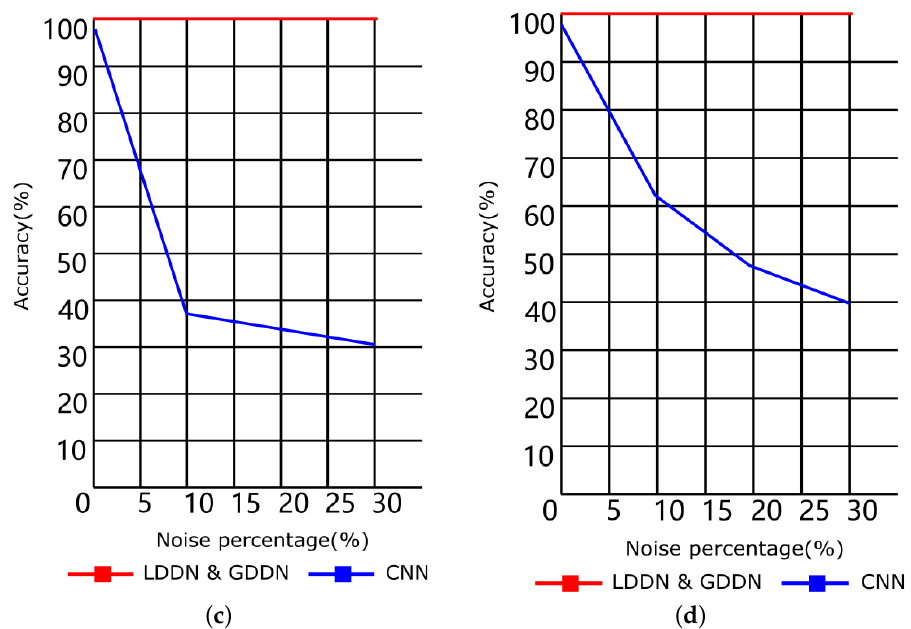
Figure 13. Line graph which compares the accuracy rates of LDDN and GDDN as well as CNN in comparison experiments with various percentages of noise added to the grayscale background. Among these four images, ( a ) depicts an experiment with the object of 4 pixels, ( b ) depicts an experiment with the object of 16 pixels, ( c ) depicts an experiment with the object of 128 pixels, and ( d ) depicts an experiment with the object of 256